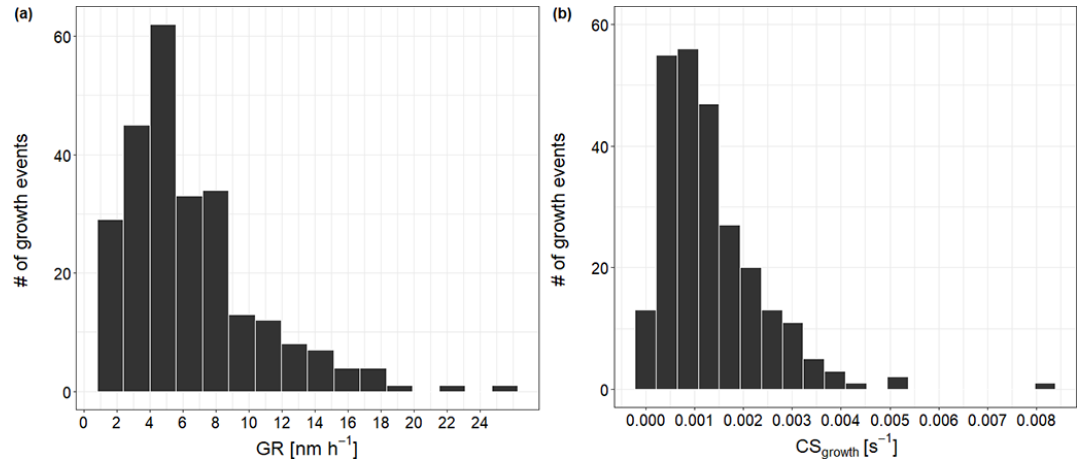
Figure 4. Histograms showing the frequency distribution of the growth rate, GR (a) , and condensation sink during the growth events, CS growth (b) , for all observed 254 particle growth